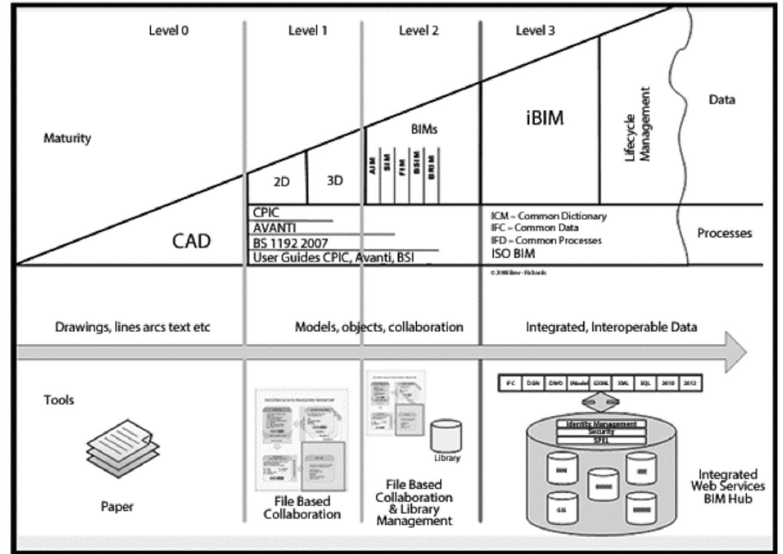
Figure 1. The BIM maturity level model by Bew and Richards (2008) [6].